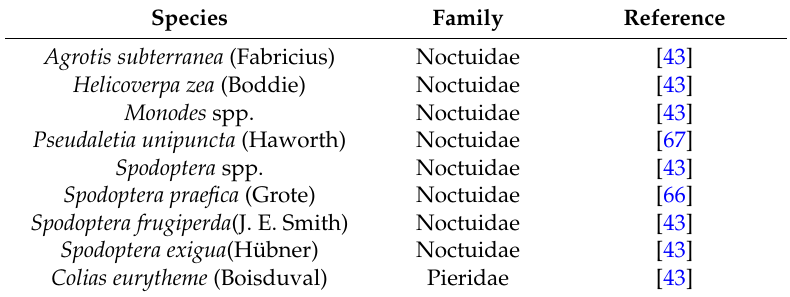
Table 7. List of known hosts of M. laphygmae in its native range prior to its introduction to Hawaii in